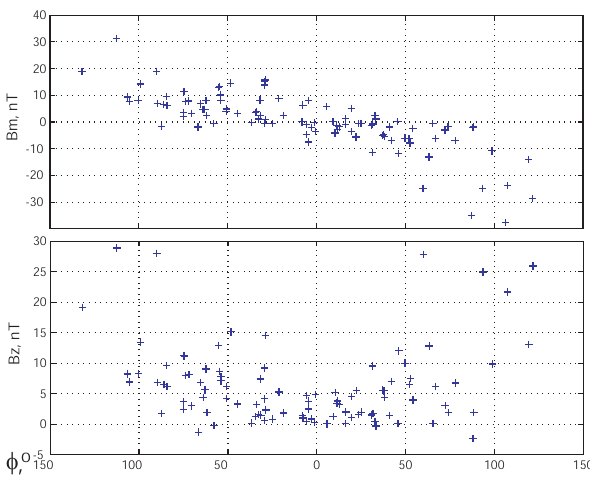
Fig. 21. Magnetic field components B m , B z relative to the current sheet normal tilt in the YZ plane (zero corresponds to normal paral- lel to Z GSM ). Events from the 2001 (Runov et al., 2006) and 2004 datasets are